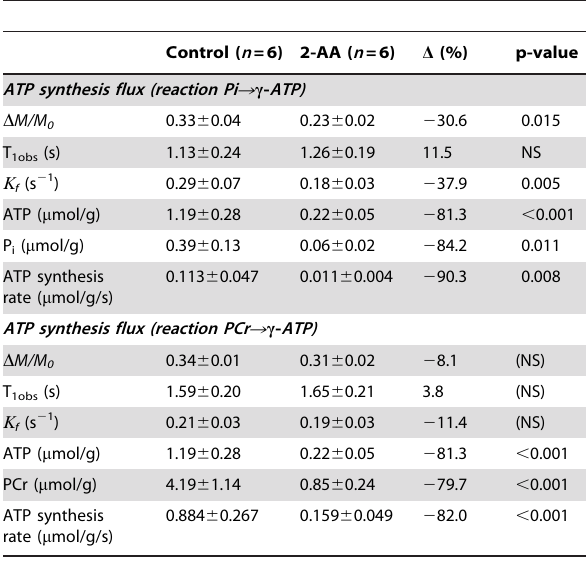
Table 1. In vivo 31 P-NMR saturation transfer analysis of limb skeletal muscle from control and 2-AA treated